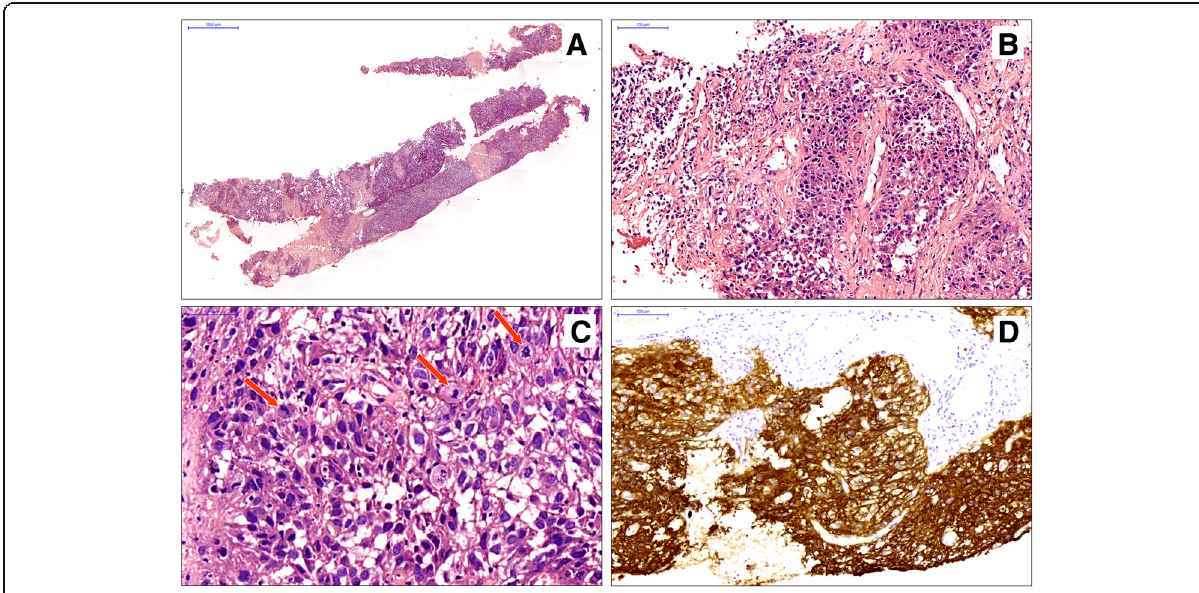
Fig. 2 Histopathological and immunohistochemical features of the core needle biopsy specimen: a Low-power view of the needle biopsy specimen. b Atypical epithelioid tumor cell nests infiltrating the hyperplastic collagen fibers mimic a metastatic carcinoma. c These tumor cells are round to polygonal with atypical mitoses (arrows) and are positive for CD23 ( d